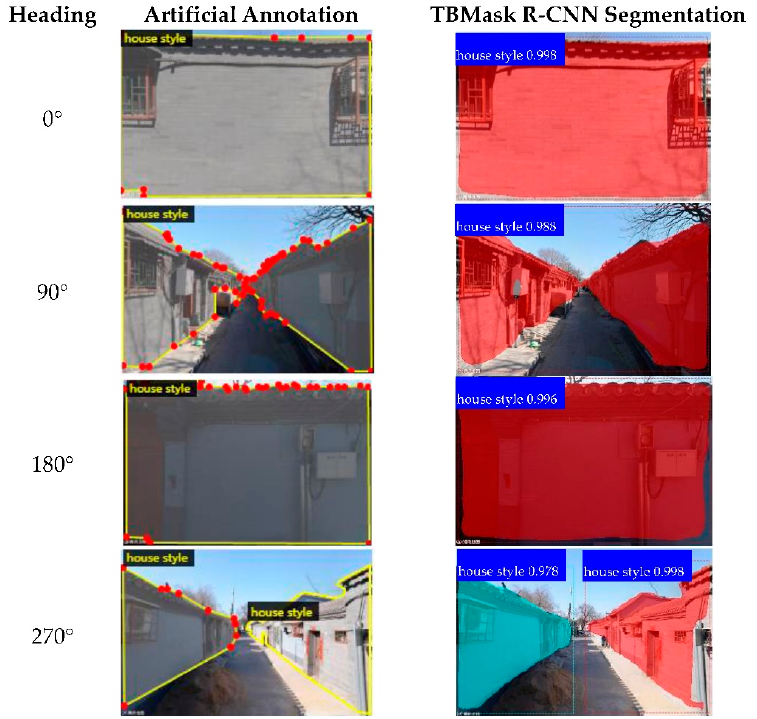
Figure 5. Comparison of the segmentation results (116.381335,